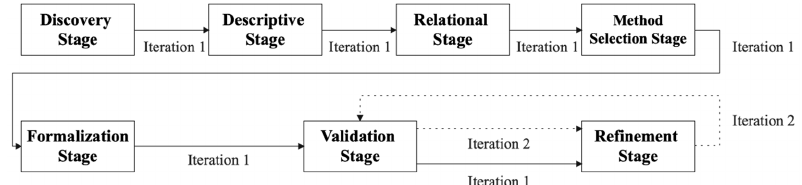
Figure 1. Overview of the process to create the methodology.